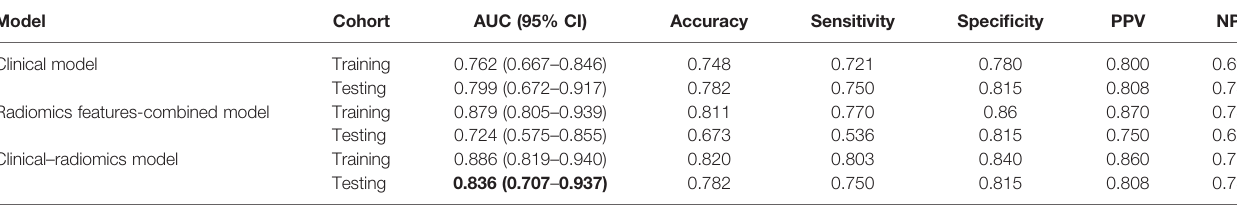
TABLE 2 | The performance of all models in predicting GAE in the training and testing cohorts.